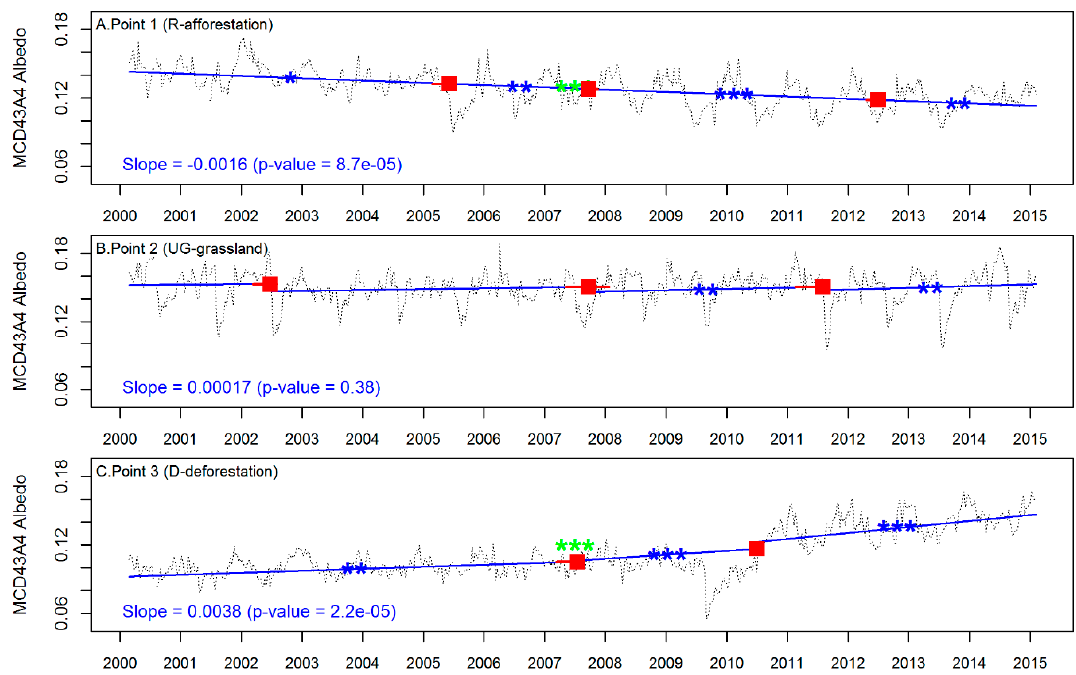
Figure 8. Estimated trends on three selected points decomposed using season-trend model (STM) in package greenbrown in R. Red squares indicate structural breaks, while blue and green stars indicate significance of trend segments.